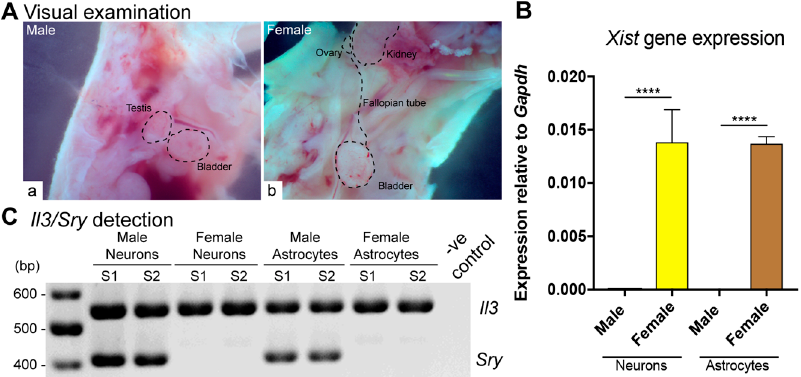
Figure 1. Culturing sex-specific neurons and astrocytes and their molecular identification. ( A ) Visual examination-based separation of male (a) and female (b) embryos based on observation of testes and ovaries, respectively. ( B ) Confirmation of sex-specific nature of cultured neurons and astrocytes using female-specific Xist gene expression. Xist transcript expression is detected only in female cells. For all